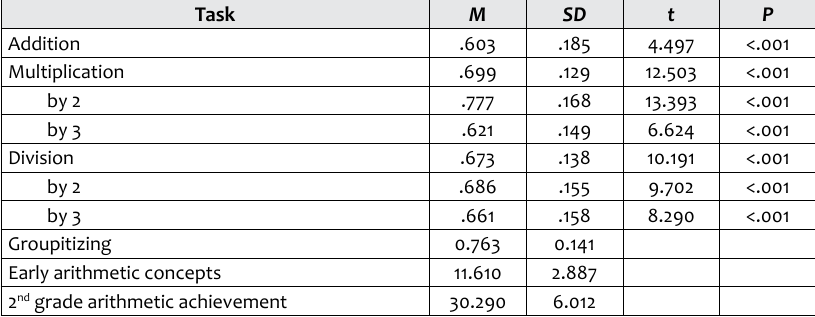
Table 2: Mean performance and standard deviation on measures of approximate arithmetic, groupitizing, early arithmetic concepts and later school Achieve- ment in Study 2; Additional t Values and Significances for Approximate Arithmetic Problems (One-sample t-Test against M = .500, df = 65).